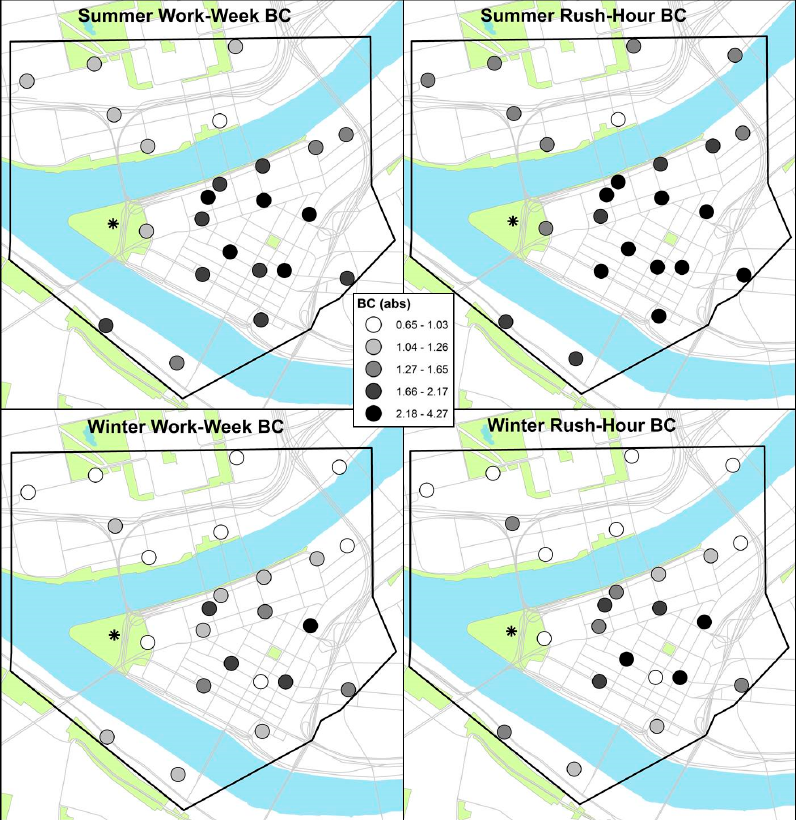
Figure 3. Paired work-week and rush-hour BC absorbance (in quintiles) across 24 distributed monitoring sites for summer ( top ) and winter ( bottom ) sampling.